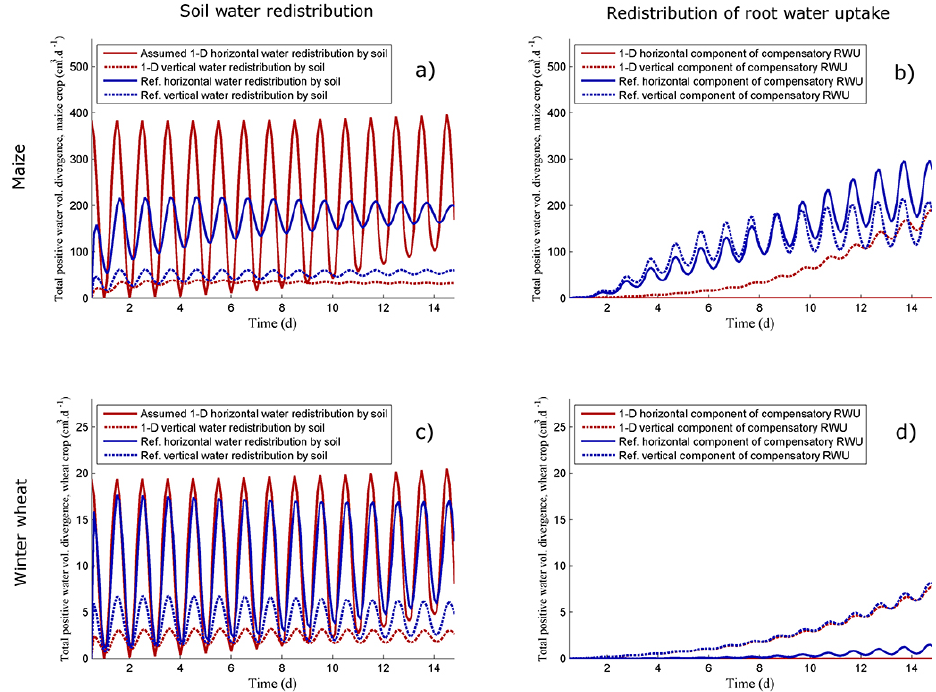
Fig. 6. Rating of processes dissipating soil water potential heterogeneity by (a, c) soil and (b, d) roots, in scenario “high T daily on silt loam”, for (a, b) maize and (c, d)